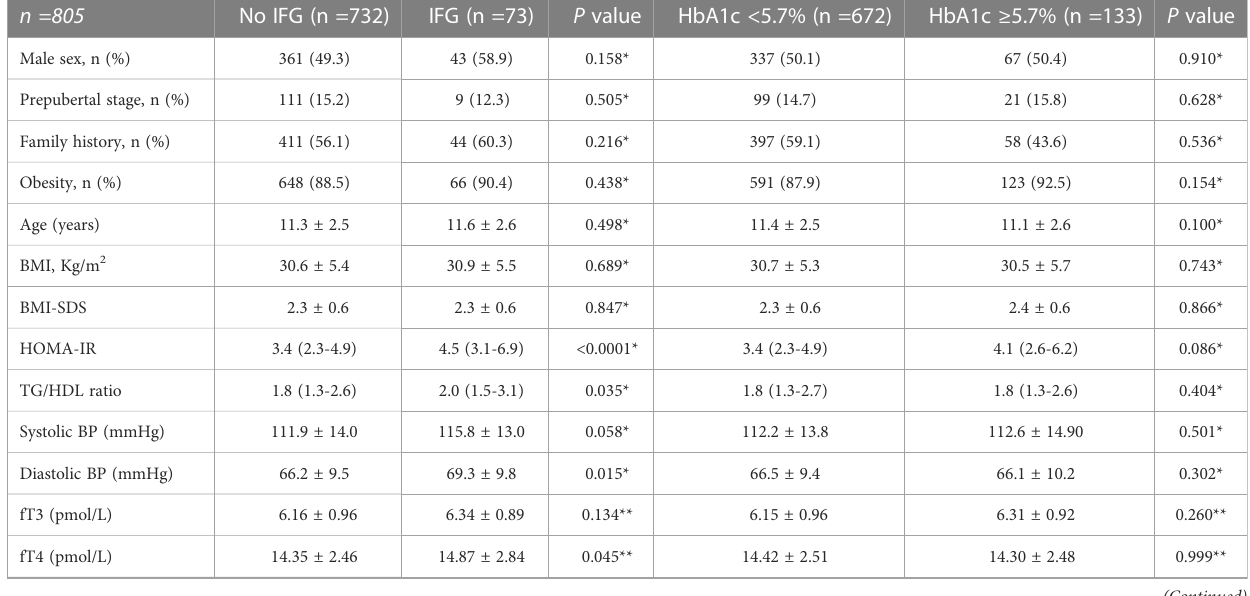
TABLE 3 Anthropometric, clinical, biochemical and thyroid variables by IFG and A1c ≥ 5.7%. n